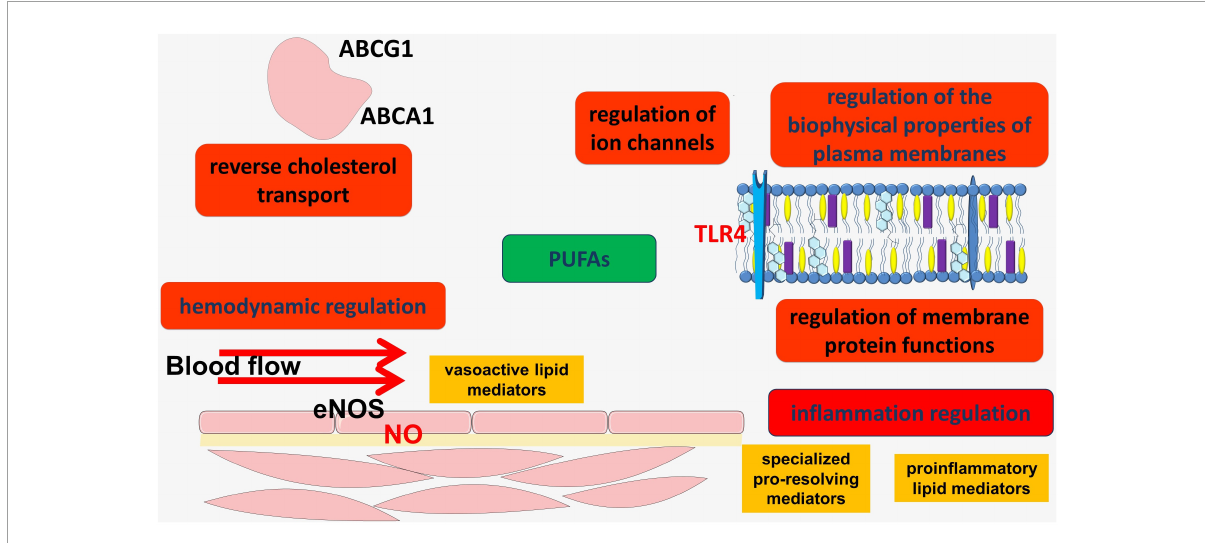
FIGURE2 Participation of PUFAs in the regulation of some processes in the vascular